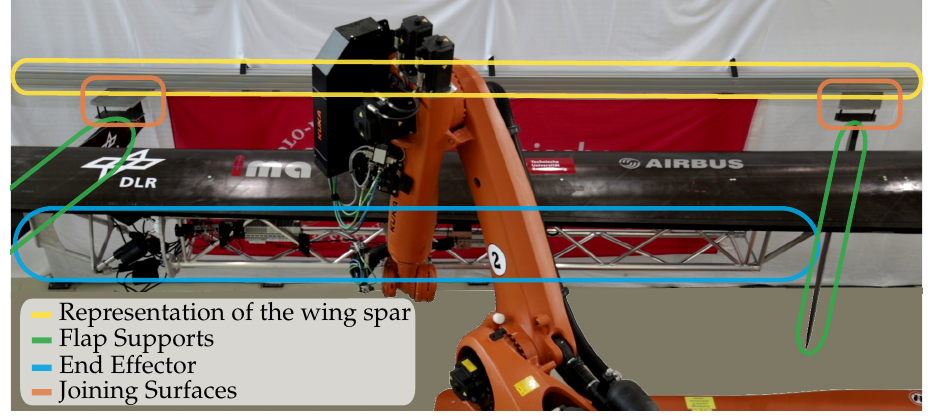
Figure 17. Mobile Robot with end effector while integrating the equipped flap to the rear spar Figure 17. Mobile robot with end effector integrating the equipped flap to the rear spar.